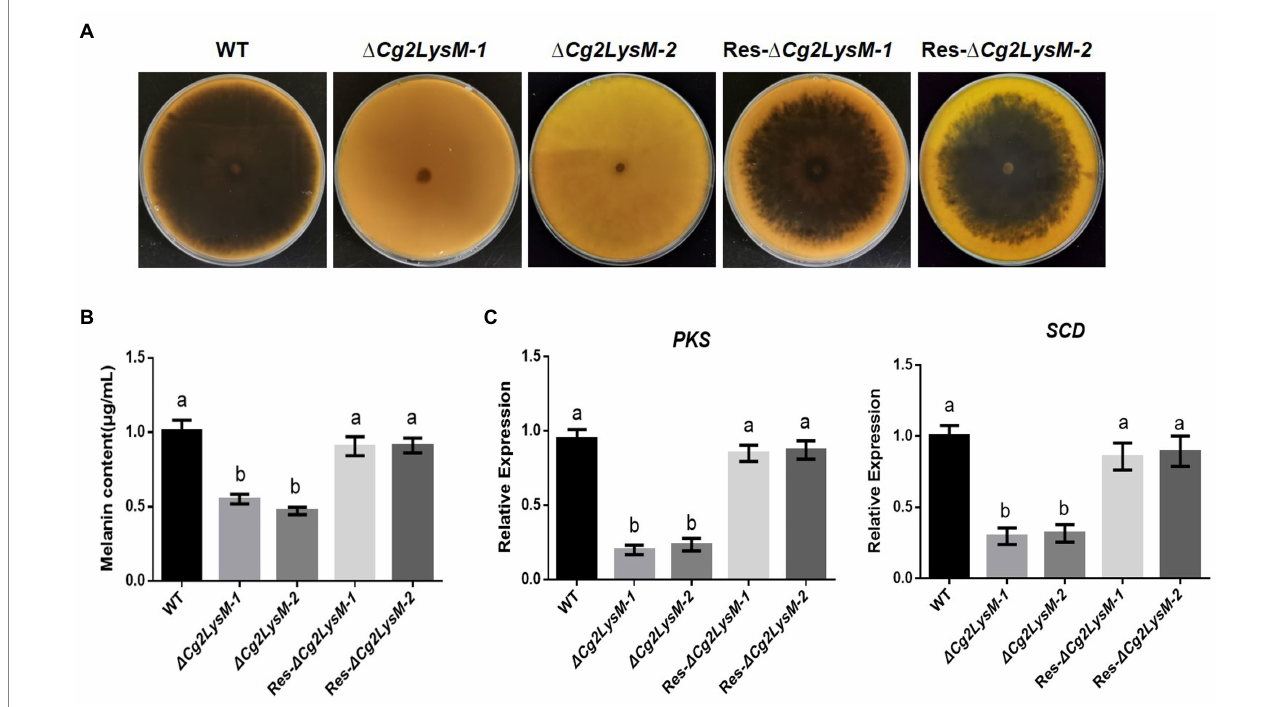
FIGURE 4 Melanin content assay of WT, Δ Cg2LysM and Res- Δ Cg2LysM strains. Colony morphology of WT, (A) Δ Cg2LysM , and Res- Δ Cg2LysM on PDA at 7 days. (B) Statistic analysis of melanin content of WT, Δ Cg2LysM , and Res- Δ Cg2LysM . (C) Relative expression assay of melanin synthesis gene CgPKS1 and CgSCD1 . Data are shown as the means ± SD from three independent experiments. Different letters above columns indicate a significant difference ( p < 0.05).